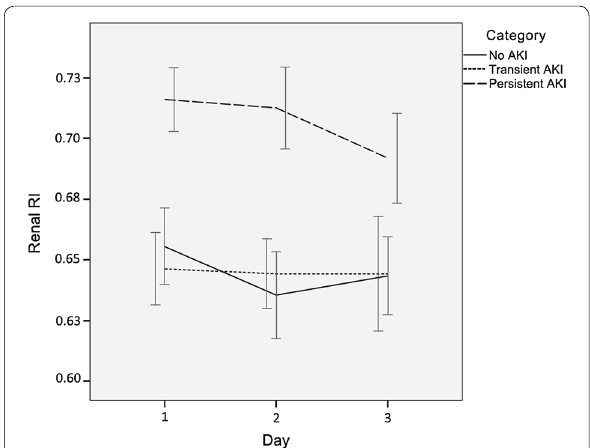
Fig. 2 Mean renal RI values according to acute kidney injury category. AKI acute kidney injury, RI renal resistive index. Error bars represent 1 standard error of the ±